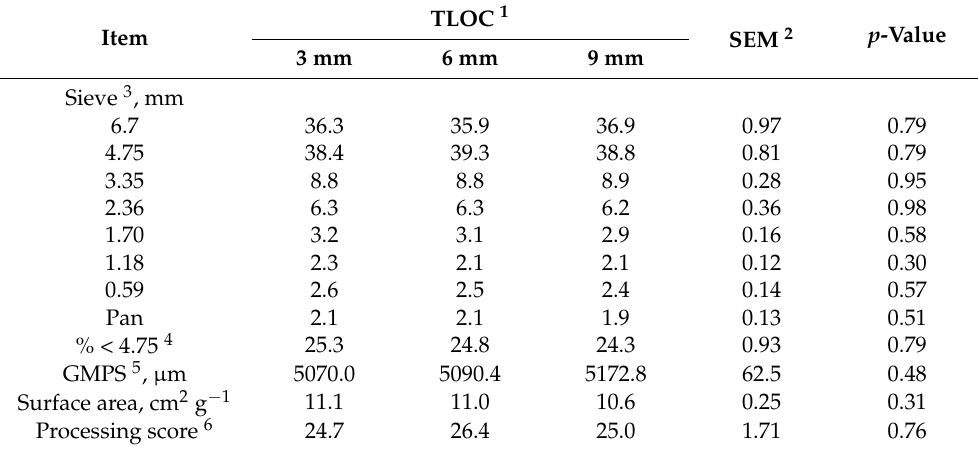
Table 4. Effect of theoretical length of cut on kernel fraction particle size distribution, geometric mean particle size, surface area and processing score in whole-plant corn silage harvested with a pull-type forage